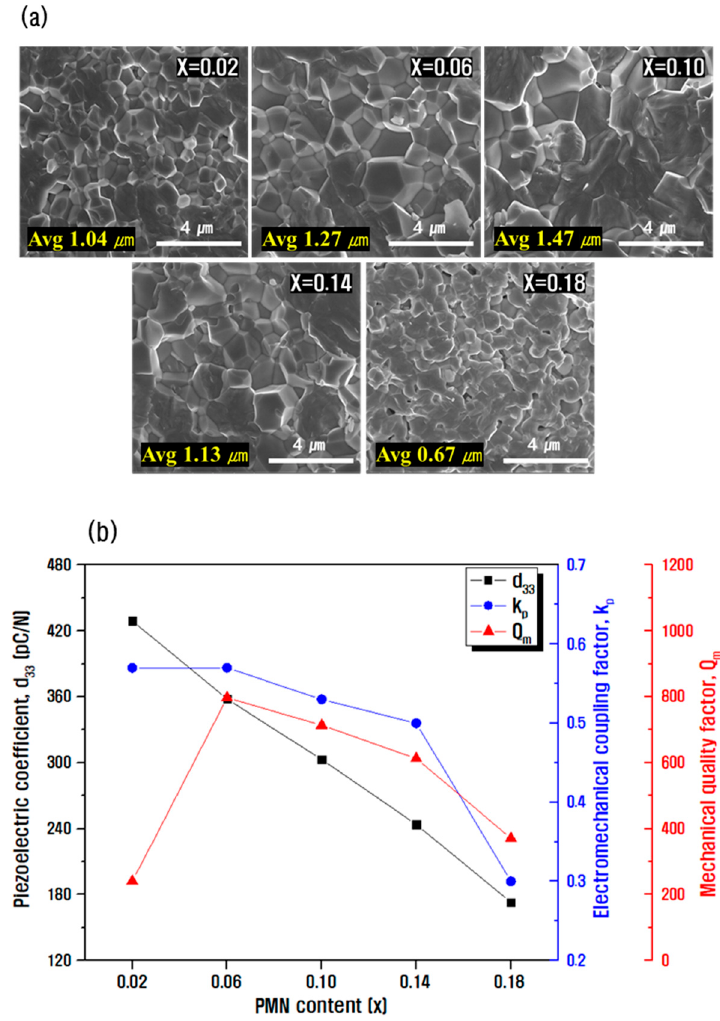
Figure 3. ( a ) FE-SEM image of fracture surfaces (Avg: the average of grain size) and ( b ) change in electrical properties represented by d 33 , k p , and Q m as a function of PMN content in (0.20 − x)PZN- xPMN-0.80Pb(Zr 0.5 Ti 0.5 )O 3 ceramic.